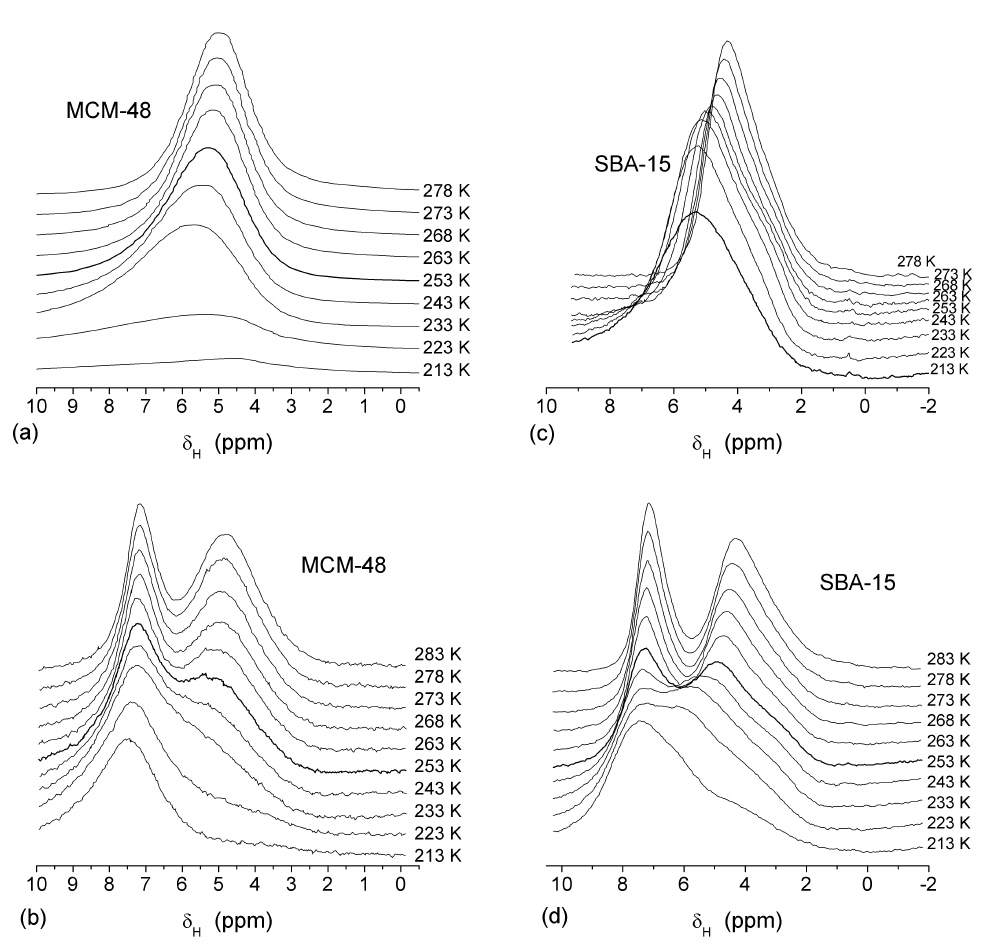
Fig. 3 Chemical shit of proton resonance of (a) water ( h = 0.2 ml/g) and (b) wa- ter/benzene mixture ( h = 0.2 ml/g, b = 0.2 ml/g) adsorbed onto MCM-48; (c) water ( h = 0.16 ml/g) and (d) water/benzene mixture ( h = 0.16 ml/g, b = 0.13 ml/g) adsorbed onto